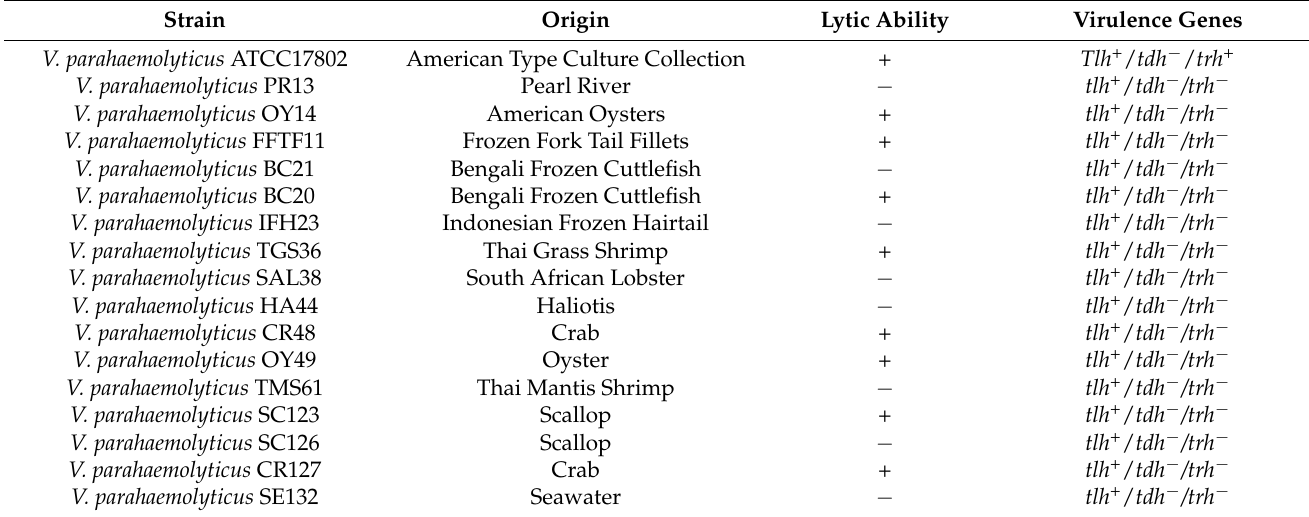
Table 1. Host range of phage